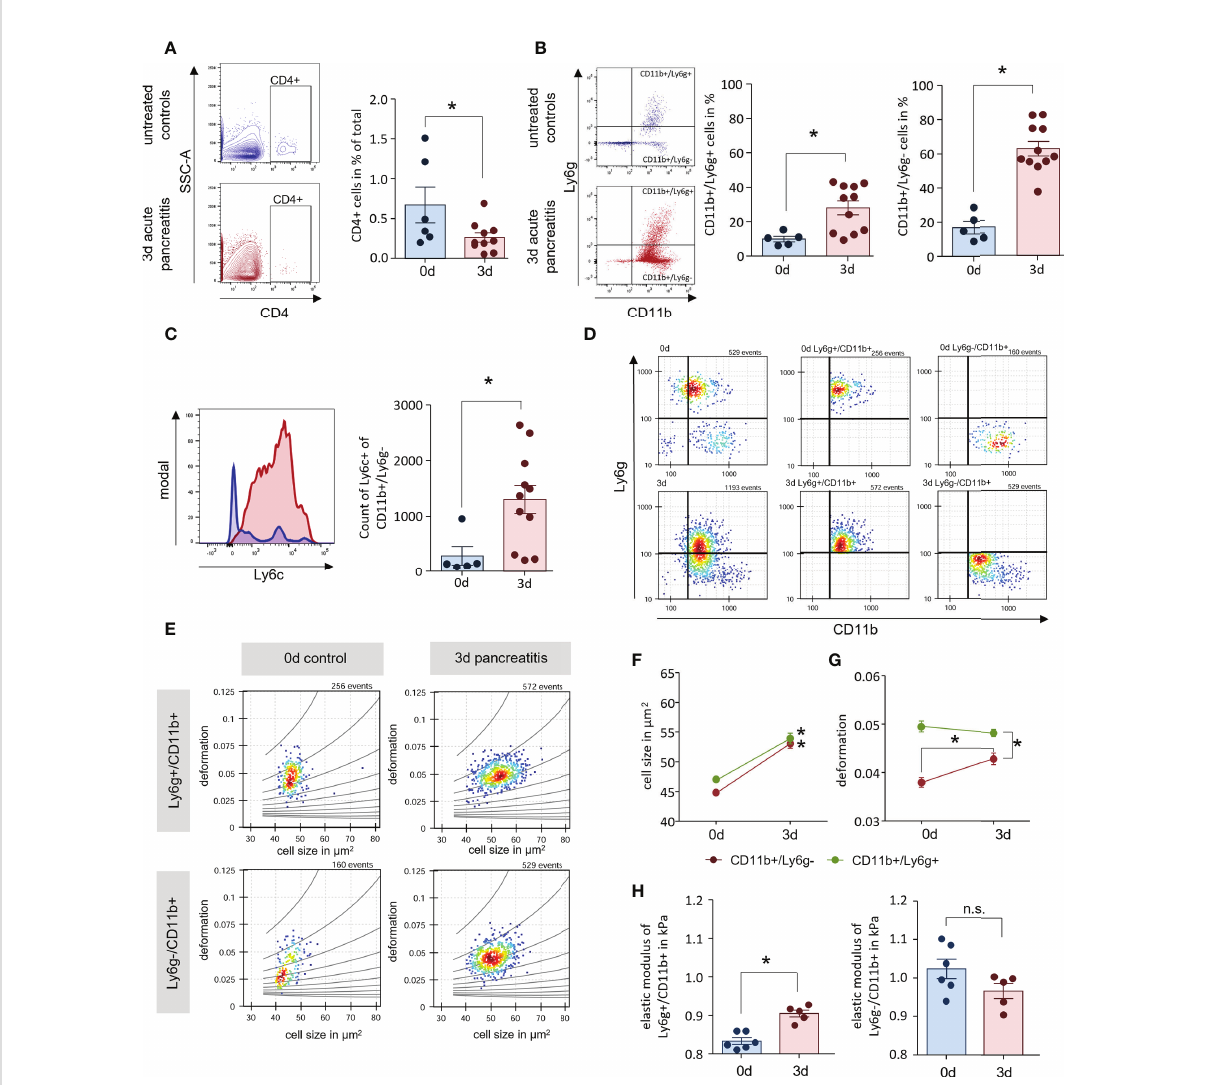
FIGURE 3 AP mice have increased numbers of enlarged blood monocytes. (A, B) Leukocyte detection from whole blood samples of AP mice and controls by fl ow cytometry analysis showed a decreased number of CD4 + T-cells in circulation, whereas CD11b + /Ly6g + and CD11b + /Ly6g - cells were found increased 3d after onset of disease. (C) Labelling of Ly6c within the population of CD11b + /Ly6g - , revealed a signi fi cant increase of monocytes during AP. (D) Their physical cell characteristics were determined by real-time fl uorescence and deformability cytometry (RT-FDC). Speci fi c Ly6g and CD11b fl uorescent antibody labelling was used to discriminate neutrophils and monocytes. (E) Scatter plots of deformation vs. cell size for CD11b + /Ly6g + neutrophils and CD11b + /Ly6g - monocytes. (F, G) Cell size is increased during SAP in both cell types (D) while the increase in deformation observed in CD11b + /Ly6g - monocytes, does not reach the deformation values of CD11b + /Ly6g + neutrophils. (H) The elastic modulus is signi fi cantly increased in neutrophils but not in monocytes. All graphs represent 5 or more animals each group, signi fi cance was tested by unpaired, two tailed student`s t-test. RT-FDC data has been analysed using linear mixed models (*p<0.05). n.s. means (not signi fi